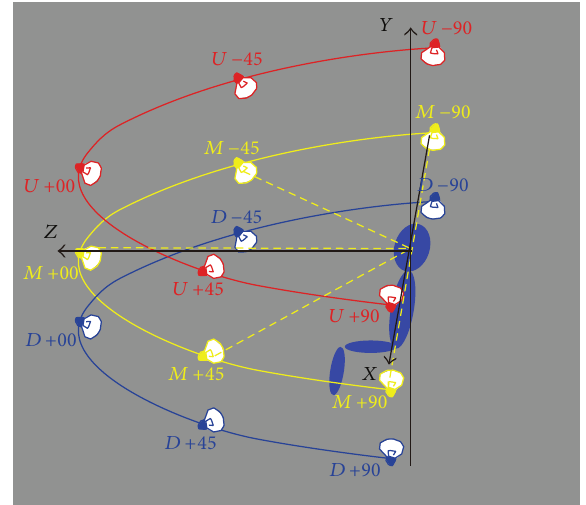
Figure 10: Lamp-house positions of CAS-PEAL face database.